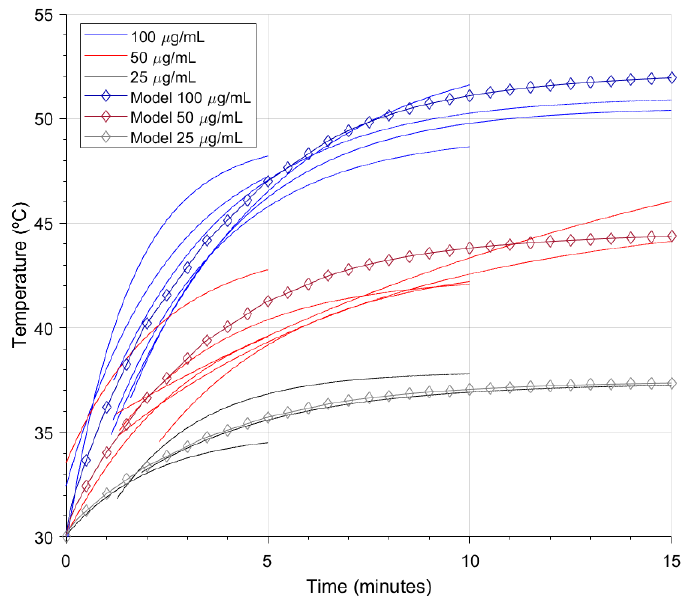
Figure 10. Temperature evolution in the model and experimental measurements when irradiating various suspension concentrations at 4 W/cm 2 808